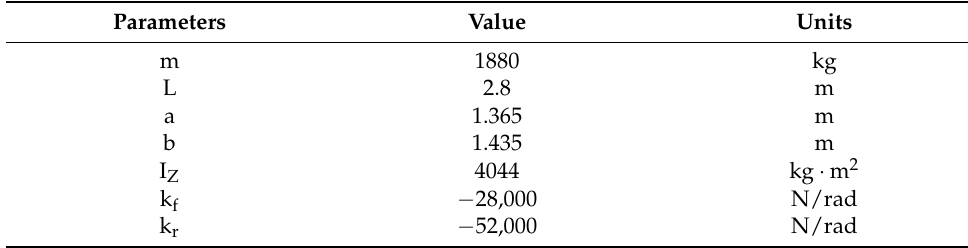
Table 1. Key parameters of the model. Parameters Value Units m